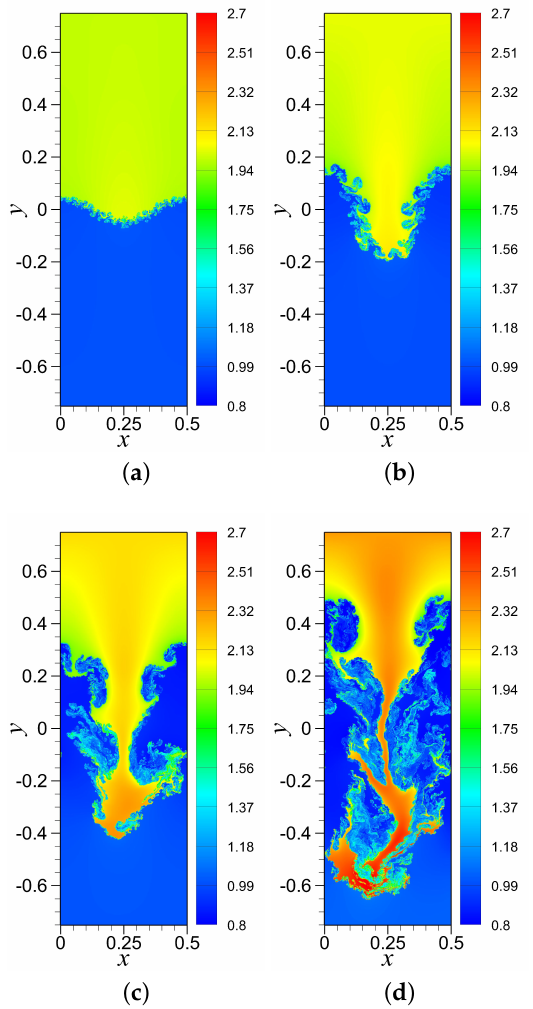
Figure 13. Time evolution of density field for the RTI problem with single-mode perturbation: ( a ) t = 1.8; ( b ) t = 2.7; ( c ) t = 3.6; ( d ) t = 4.5. Results are obtained by the ILES-Roe scheme at a resolution of 8192 ×